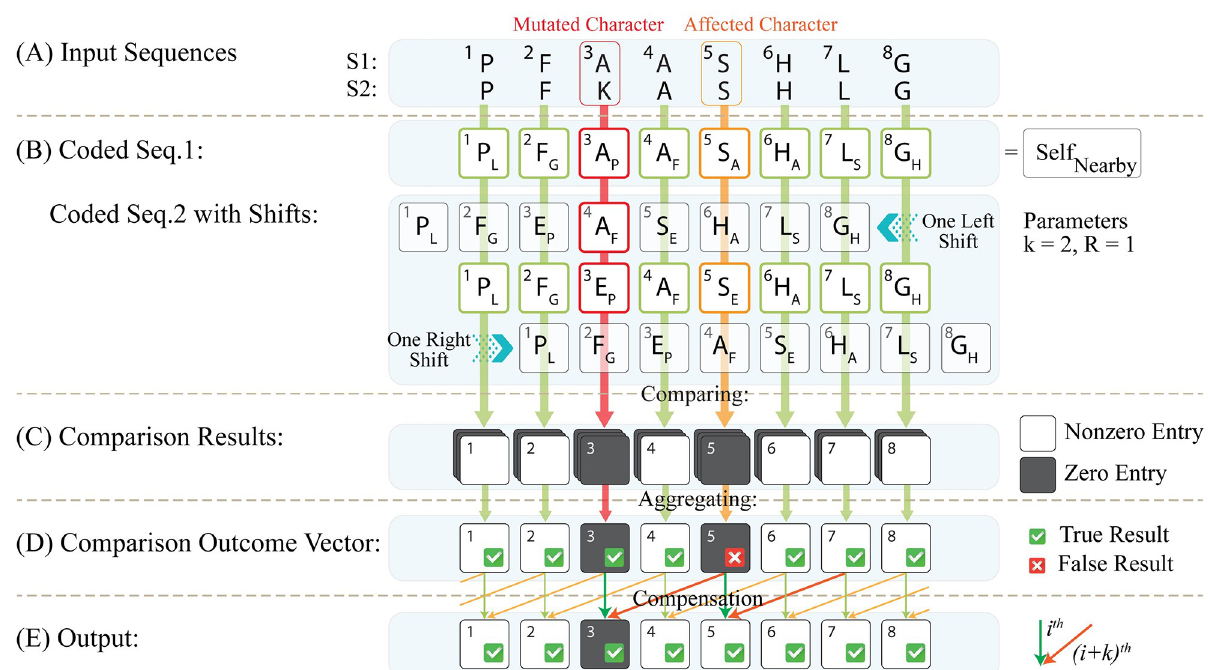
Fig 3. Step-by-step progress of the S 1 -align operation of the HELIOS method for optical sequence alignment. (A) Two input sequences, i.e S 1 and S 2 , are given to the HELIOS method, assuming the third character (i.e. ‘A’ in S 1 and E in S 2 ) is mutated. (B) S 1 and S 2 are coded based on the proposed coding procedure, assuming k = 2 and R = 1. While the self-label codes of the third character are different for S 1 and S 2 , the nearby-label codes of the fifth characters (i.e. ‘S’) are different as well, due to the mutated character, assuming k = 2. Afterward, the coded S 2 is shifted one time horizontally towards the left and right of the coded S 2 assuming R = 1. Then, the main S 1 is compared with the main S 2 and all its shifts, and hence, (C) the comparison results are presented for each comparison. (D) Next, the comparison output vector is formed by aggregating all the comparison results, where the matched characters result in nonzero entries. As represented with the zero entry, the mutated character in position 3 within the input sequences is successfully located due to the different self-label codes, while the 5 th character is false mismatched due to the different nearby-label codes. (E) To compensate for this false mismatch, the i th entry of the output is determined according to aggregating the i th and the ( i + k ) th entries of the comparison outcome vector. Hence, the 5 th entry is recovered by the corresponding nonzero value at the 7 th entry; while proper detection of character mutation at the 3rd entry is not